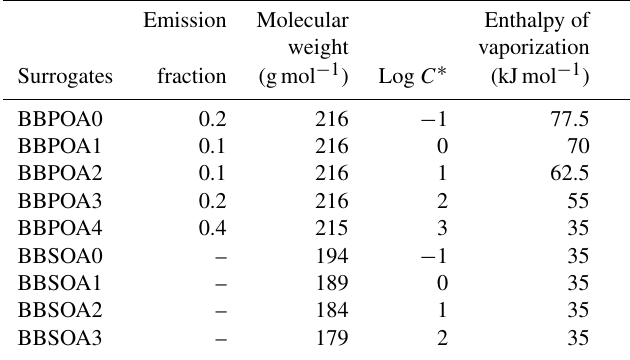
Table D2. Properties of the VBS species (primary and secondary